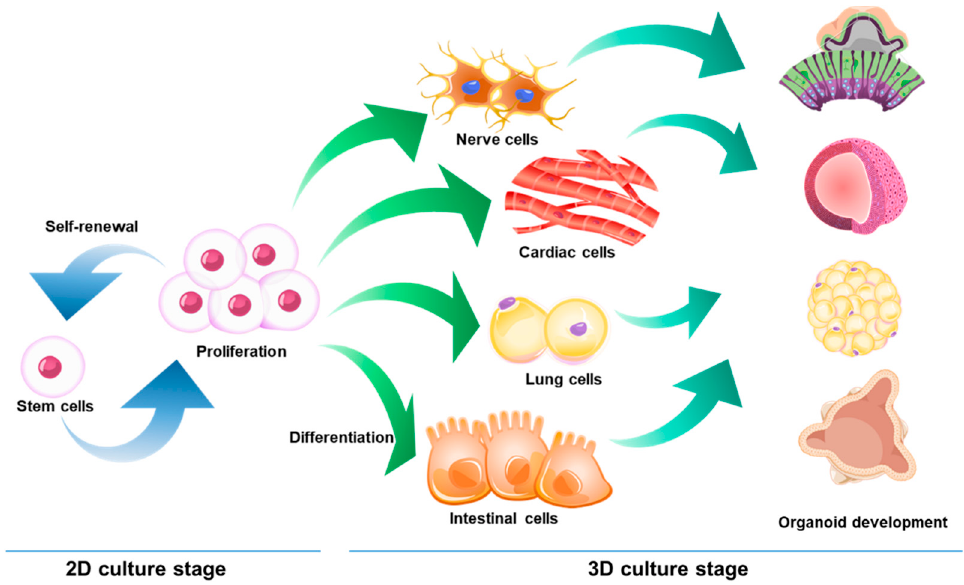
Figure 2. Stem cell-derived organoids.